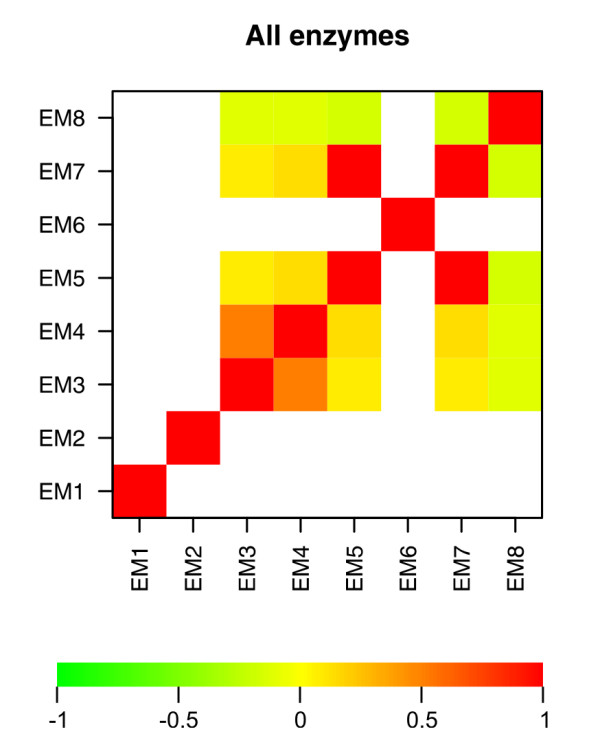
General correlations between elementary mode fluxes. Correlations between variations of pairs of elementary mode fluxes under random variation of all kinetic parameters of all enzymes. Values are colour-coded according to the bar at the bottom of the figure. White squares indicate that no correlation coefficient could be calculated, i.e. that one of the two elementary modes retained a constant flux value.